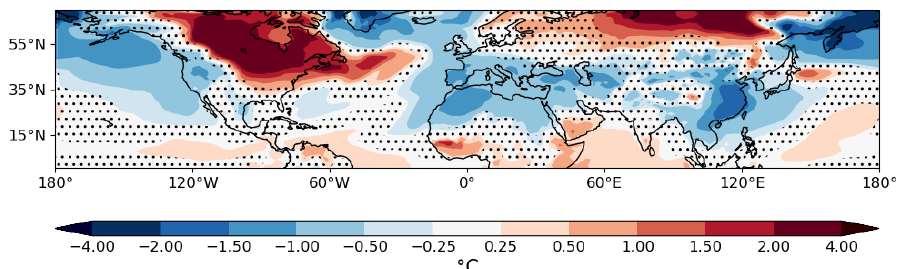
Figure 10. The difference (G6abs − G6sulfur) in the DJF near-surface temperature between G6abs (2065–2084) and G6sulfur (2081–2100). Stippling represents areas that are not significant at the 5% level using a two-tailed t -test.